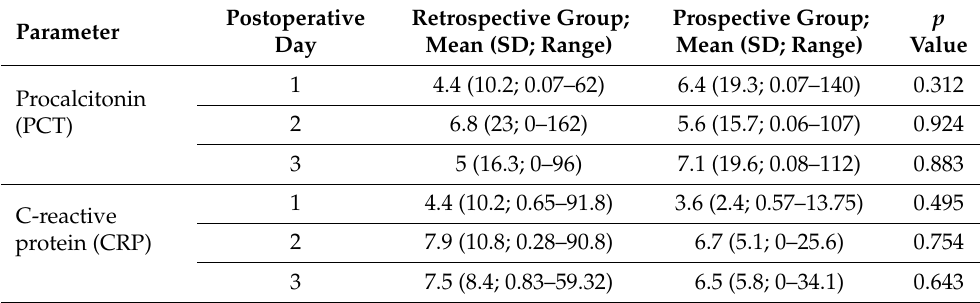
Table 2. Inflammatory parameters values in the first three postoperative